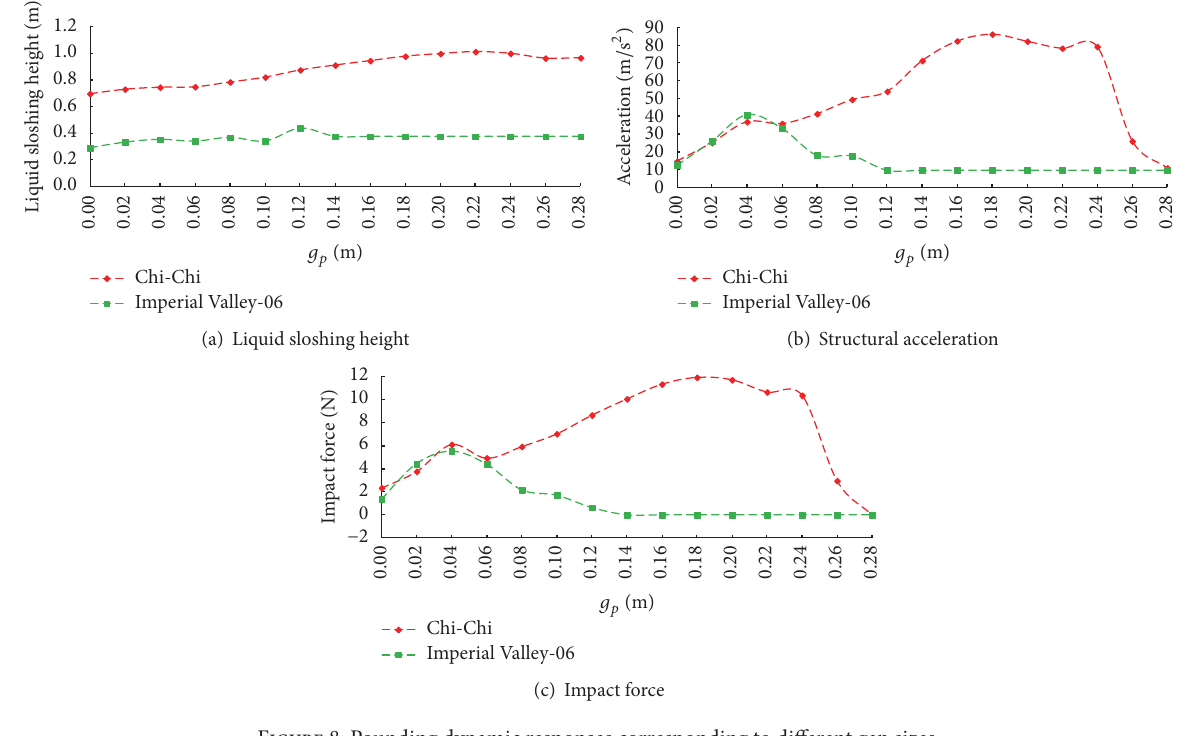
Figure 8: Pounding dynamic responses corresponding to different gap sizes.